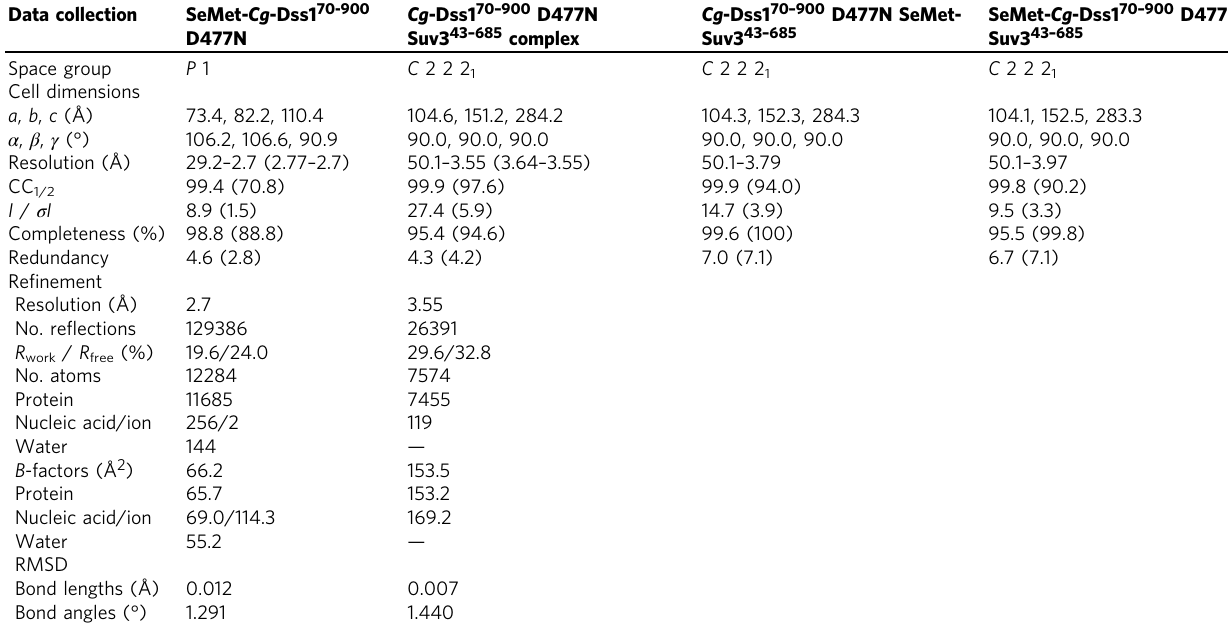
Table 1 Data collection and re fi nement statistics Data